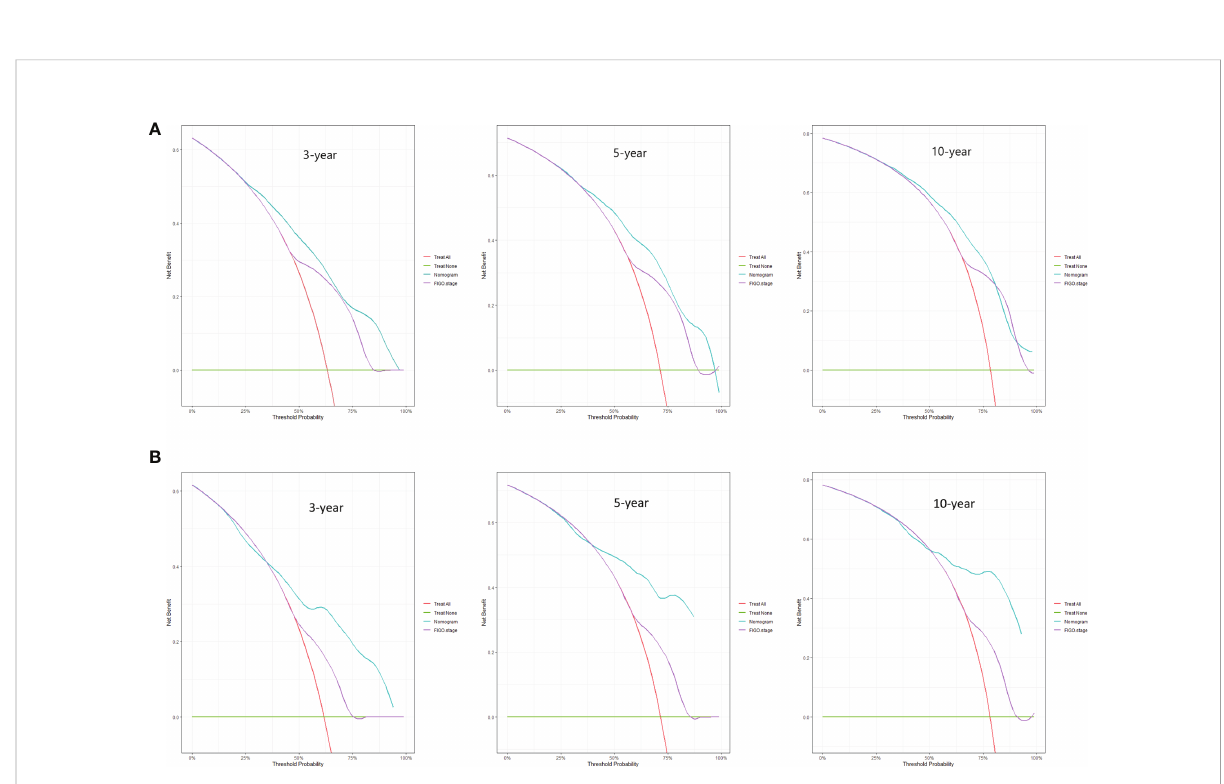
FIGURE 5 DCA curves for 3-, 5-, and 10-year OS among ECCC patients with FIGO stage III/IV within the training cohort (A) and validation cohort (B)